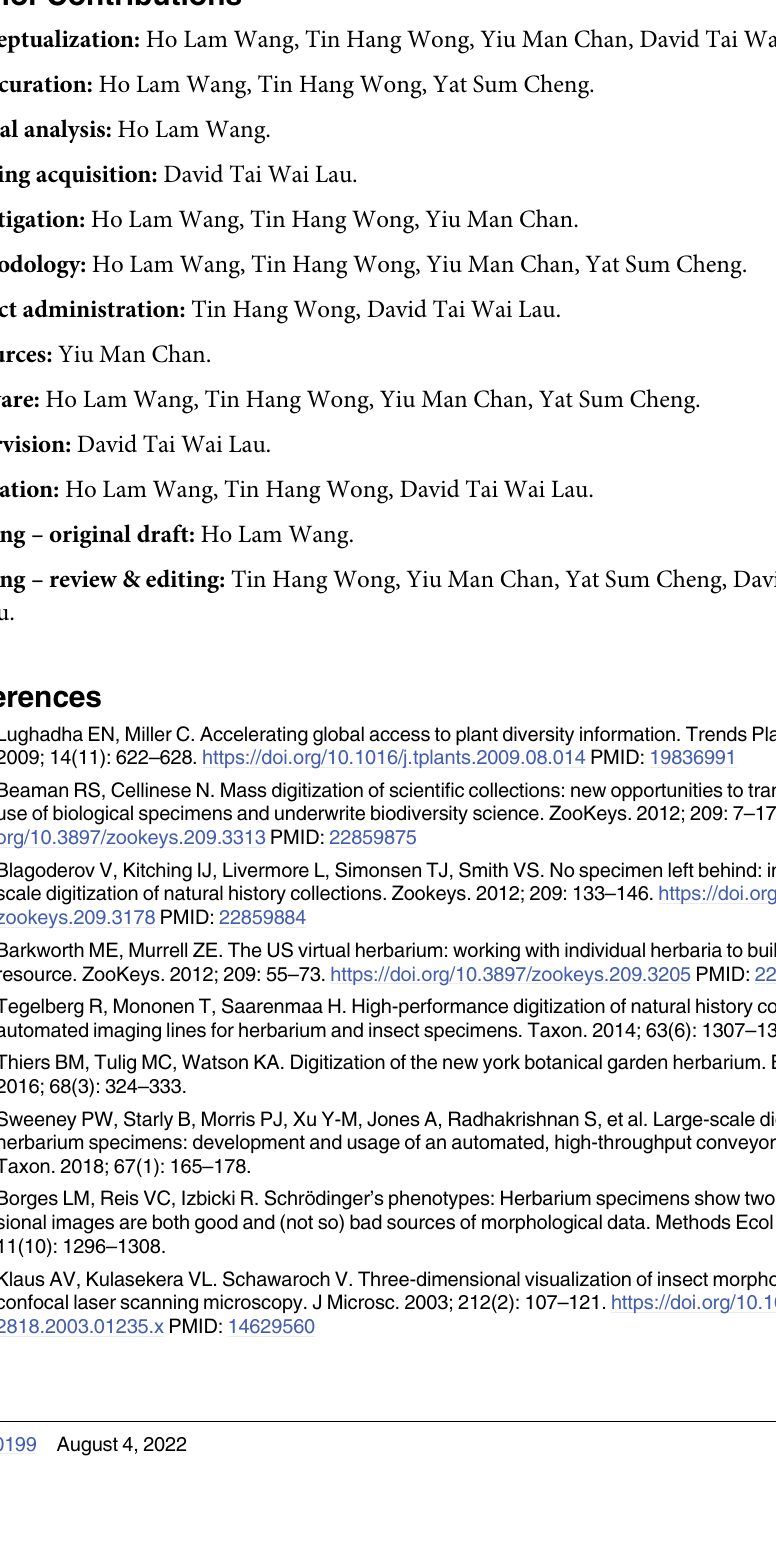
S1 Table. Carpological materials adopted in this study for 3D model reconstruction. The carpological specimens no., species name, carpological parts, size and voucher specimens